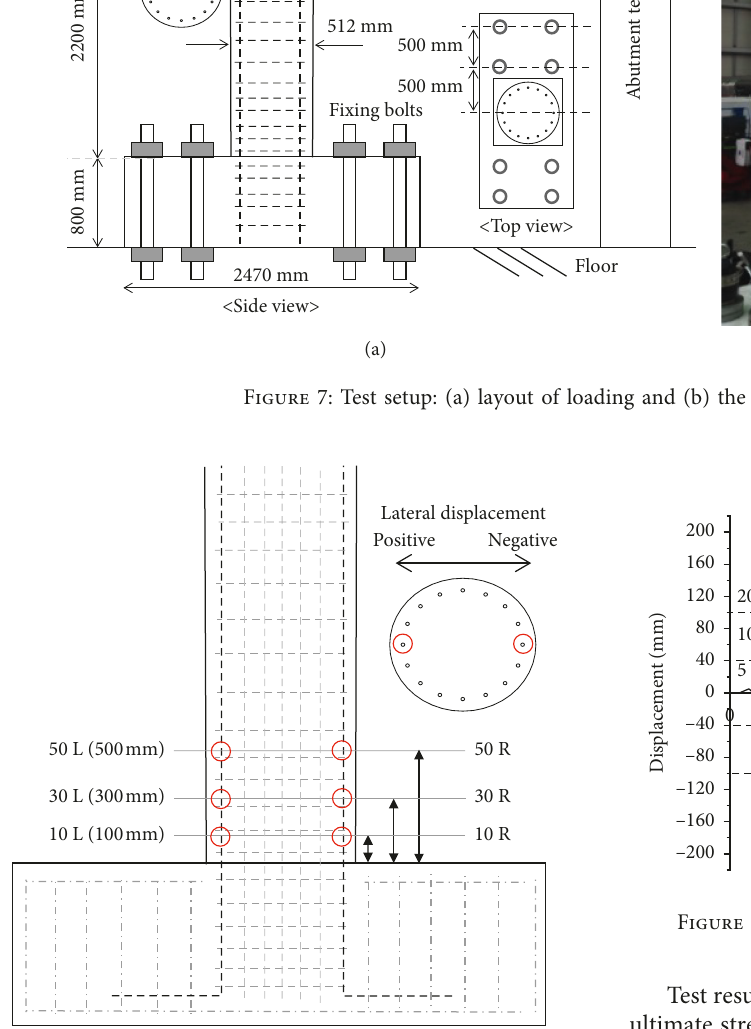
Figure 8: The location of the strain gauges.